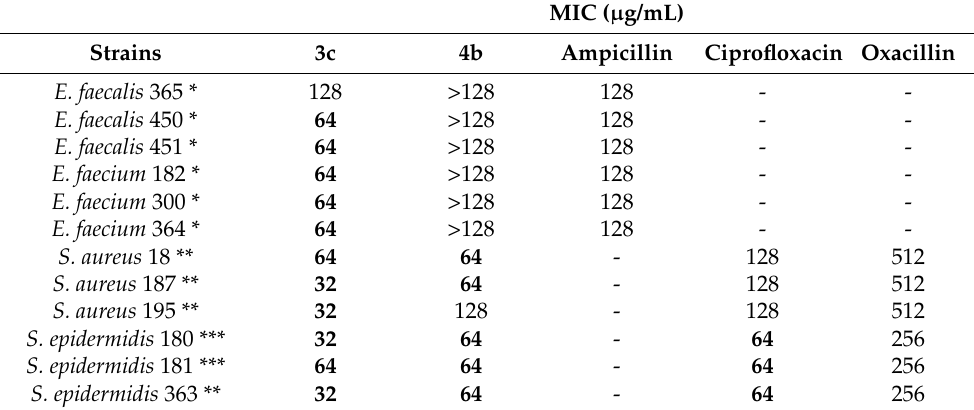
Table 5. MIC values of compounds 3c and 4b against the most clinically relevant bacteria of the Gram-positive species, obtained from experiments carried out at least in triplicate, and those of reference antibiotics expressed as µ g/mL. MIC ( µ